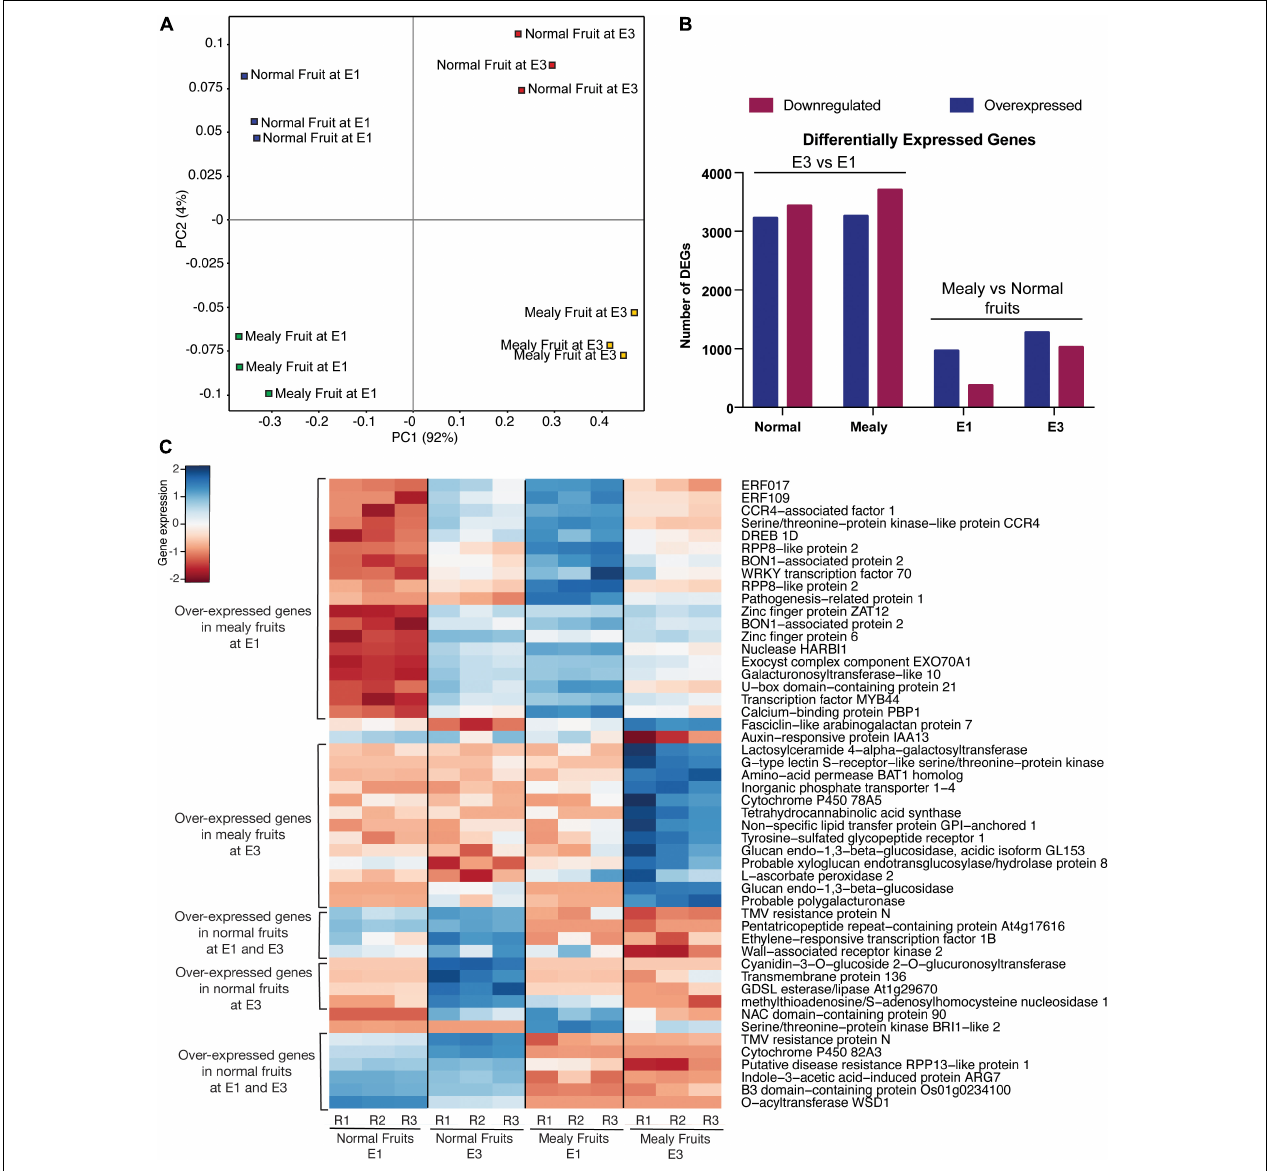
FIGURE 5 | Transcriptomic profile of P.persica fruits susceptible and resistant to mealiness. (A) Principal Component Analysis (PCA) of global gene expression in normal (resistant) and susceptible fruits at E1 and E3. (B) Number of differentially expressed genes (DEGs) at E3 vs. E1, and in mealy vs. normal fruits. (C) Heatmap of the top 50 DEGs with higher variance in their transcript level between normal fruits and mealy fruits. Color key indicates the median log2 TMM-normalized values, where red to blue represents low to high levels of transcript,